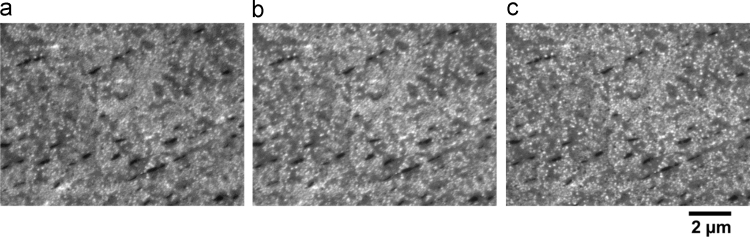
Enlarged in-lens SE images showing SiO2 particle pattern on the sample surface at (a) 0%, (b) 2% and (c) 5% global strain. The scale bar of all images is given below (c).